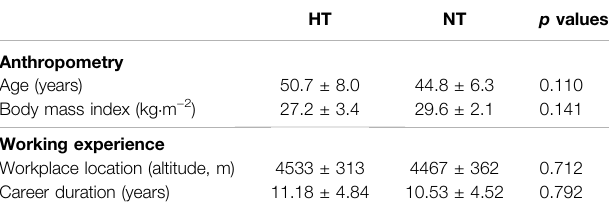
TABLE 1 | Sample ’ s demographic characteristic.